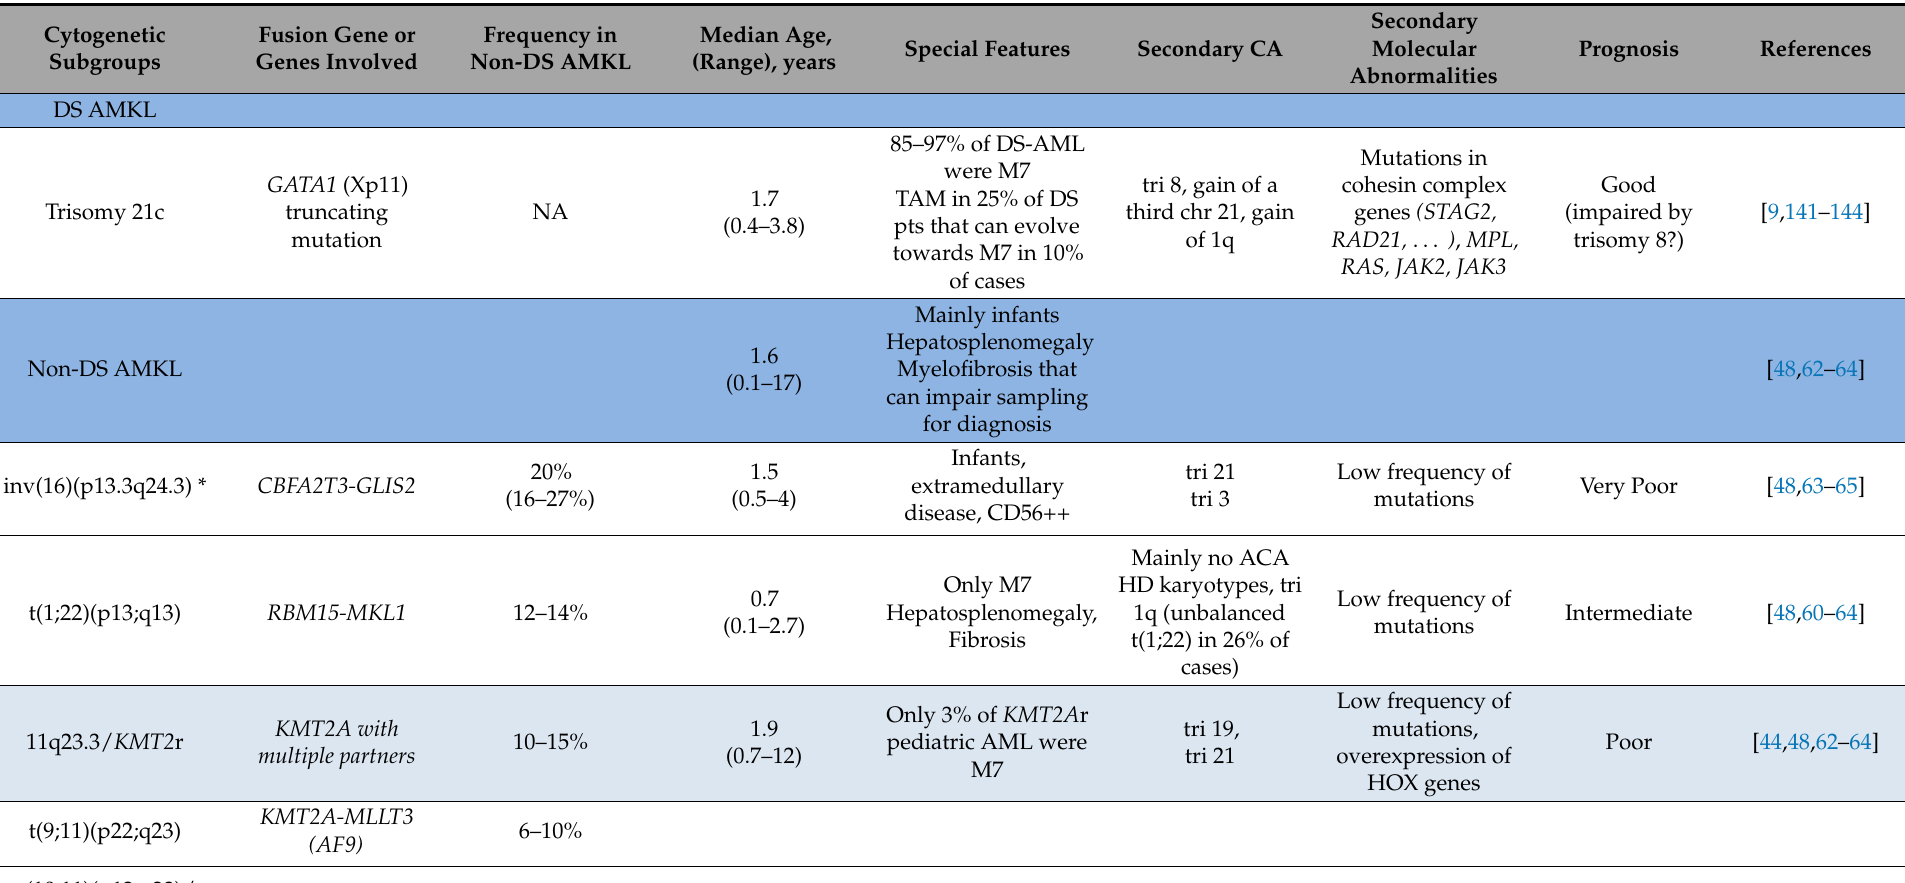
Table 2. Main cytogenetic subgroups in pediatric